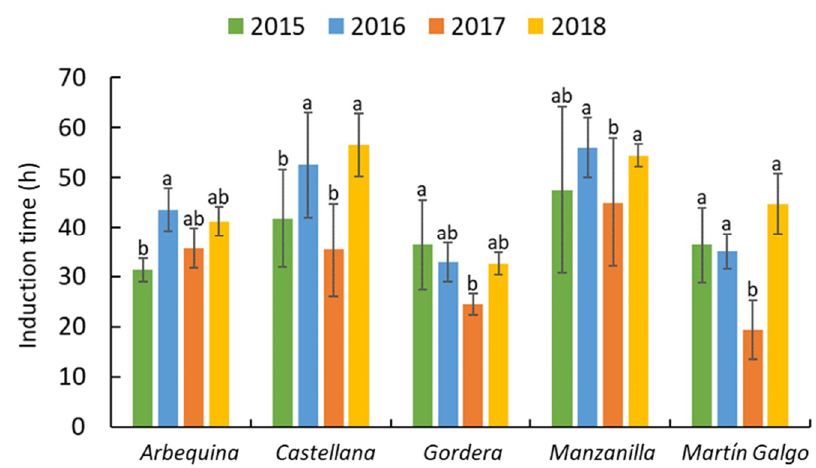
Figure 7. Oxidative stability of the monovarietal oils produced with the varieties of olives grown in the Aceite de la Alcarria PDO during the four consecutive olive crop seasons under study. Mean values of the samples elaborated in each season. Different letters within each variety indicate significant differences among seasons (Duncan test, p < 0.05).